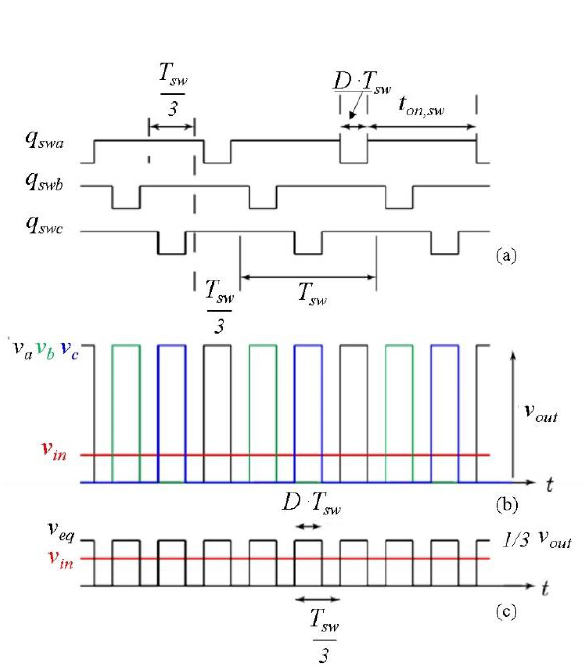
Figure 3. Switching waveforms behavior in the case of D < 1 / 3. ( a ) Gate control signal, ( b ) single-stage voltage behavior compared with the input voltage v in , ( c ) equivalent voltage behavior. It shows a frequency 3 . f sw compared to the v a, v b , and v c voltages, while the amplitude is one-third.